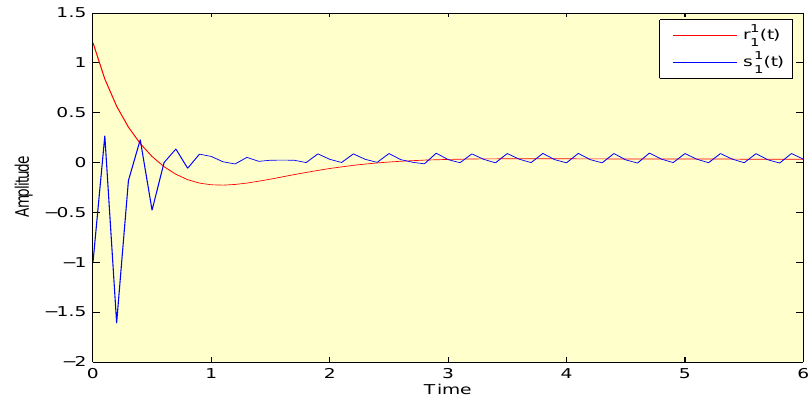
( t ) , (cid:115) 1 ( t ) of NN models (1) and (3). 1 1